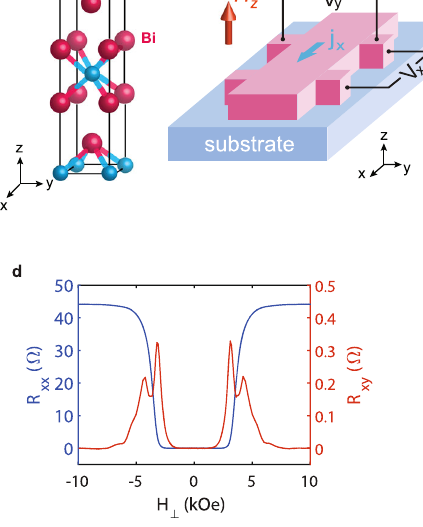
oxidizedSiand YIG substrates without applied magnetic fi eld. d R xx (blue line)and fi eld for 50nm Bi R xy (red line) versus magnetic 2 Pd/YIG. e Zoomed-in details of d Themagnetic fi eldisappliedperpendiculartothe fi lmplane.Thedot-dashedline corresponds to the critical fi eld (H c 2